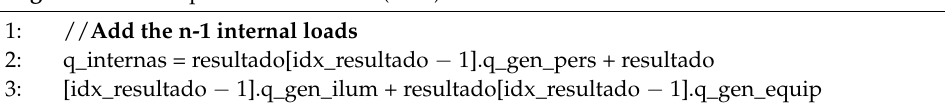
and yields the internal loads of the evaluated house (according to Algorithm 3). Algorithm 3. Compute internal loads (2.2.6)